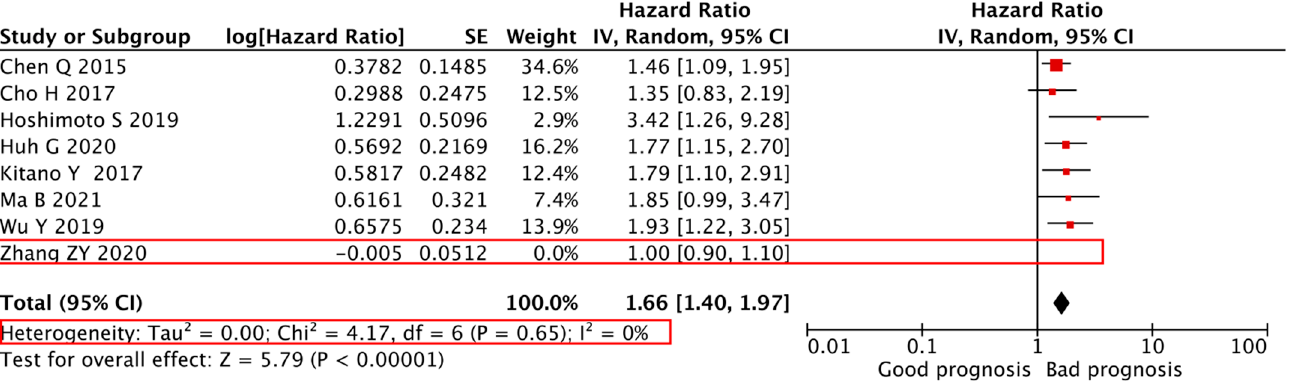
Figure 4. Sensitivity analyses of the association between the PLR and DFS in CCA patients. Sensitivity analyses of the association between the PLR and DFS of 8 studies. A random-effects model was used. DFS, disease-free survival; PLR, platelet-to-lymphocyte ratio.